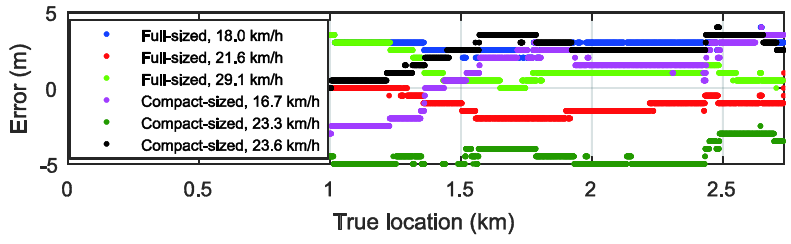
Figure 19. Estimation errors (window size = 500 m).